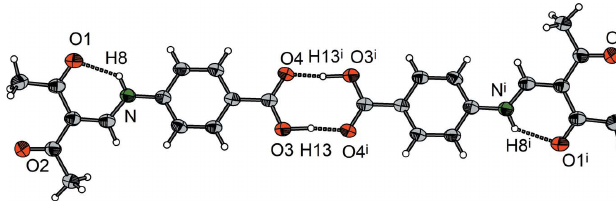
Figure 10 Section of the crystal structure of 3 showing the hydrogen-bonding pattern (dashed lines). Symmetry codes refer to Table